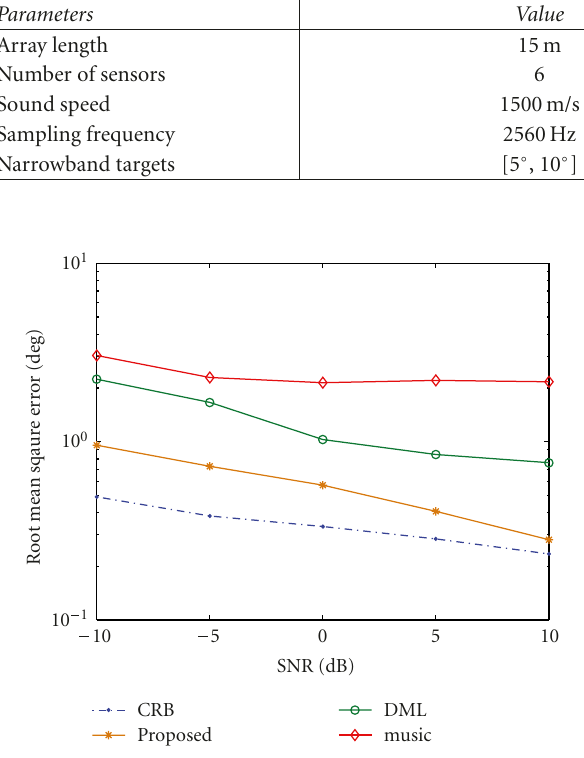
Figure 7: RMSE and CRB versus SNR (dB) for deterministic maxi- mum likelihood (DML), music, and proposed method, two targets in measured underwater noise, snapshots =